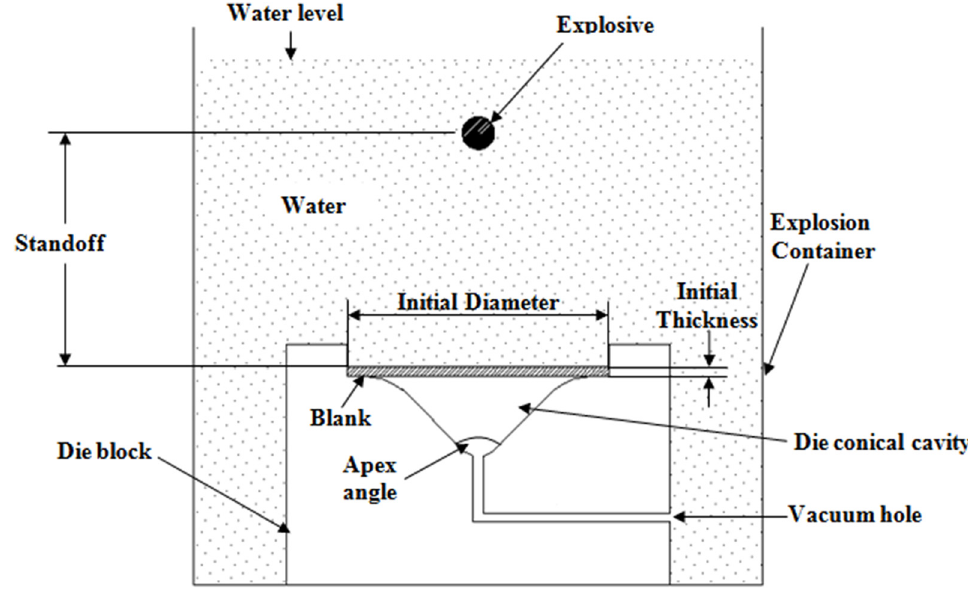
Fig. 1. Schematic diagram of an open die system used in cone explosive